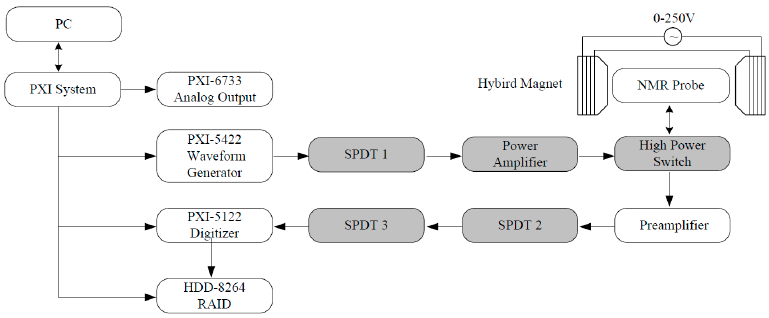
Figure 1. Schematic diagram of the NMR system, all gray parts are controlled by PXI-6773.